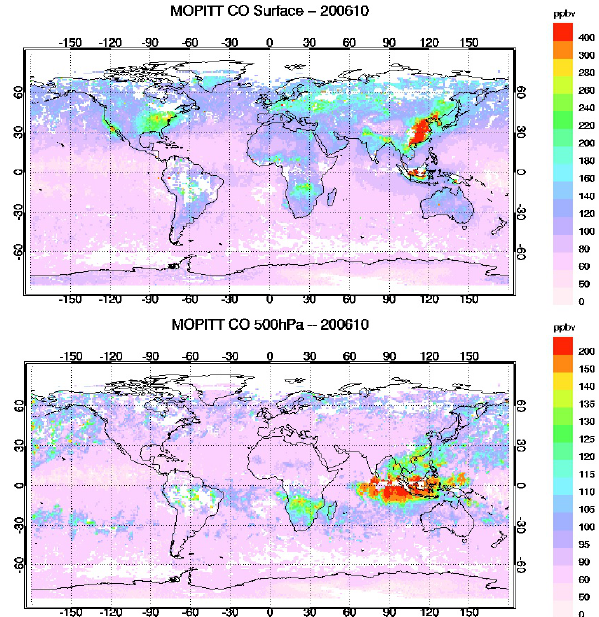
Fig. 1. (a) Surface CO estimates (version 5 release) from the Terra MOPITT satellite for October 2006. (b) Tropospheric CO estimates (version 5 release) from the Terra MOPITT satellite for October